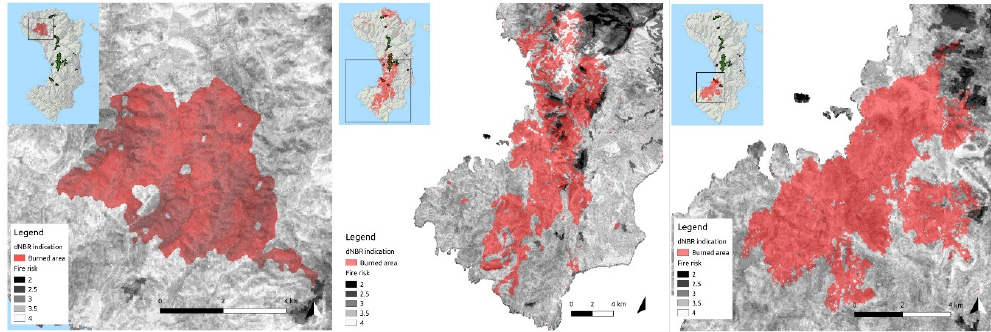
Figure 8. The burned area estimated from the dNBR of the dual Landsat-8 OLI images for the fires in 2007 (left), 2012 (middle), and 2016 (right) laid over the fire risk map produced from the multi-criteria model proposed.